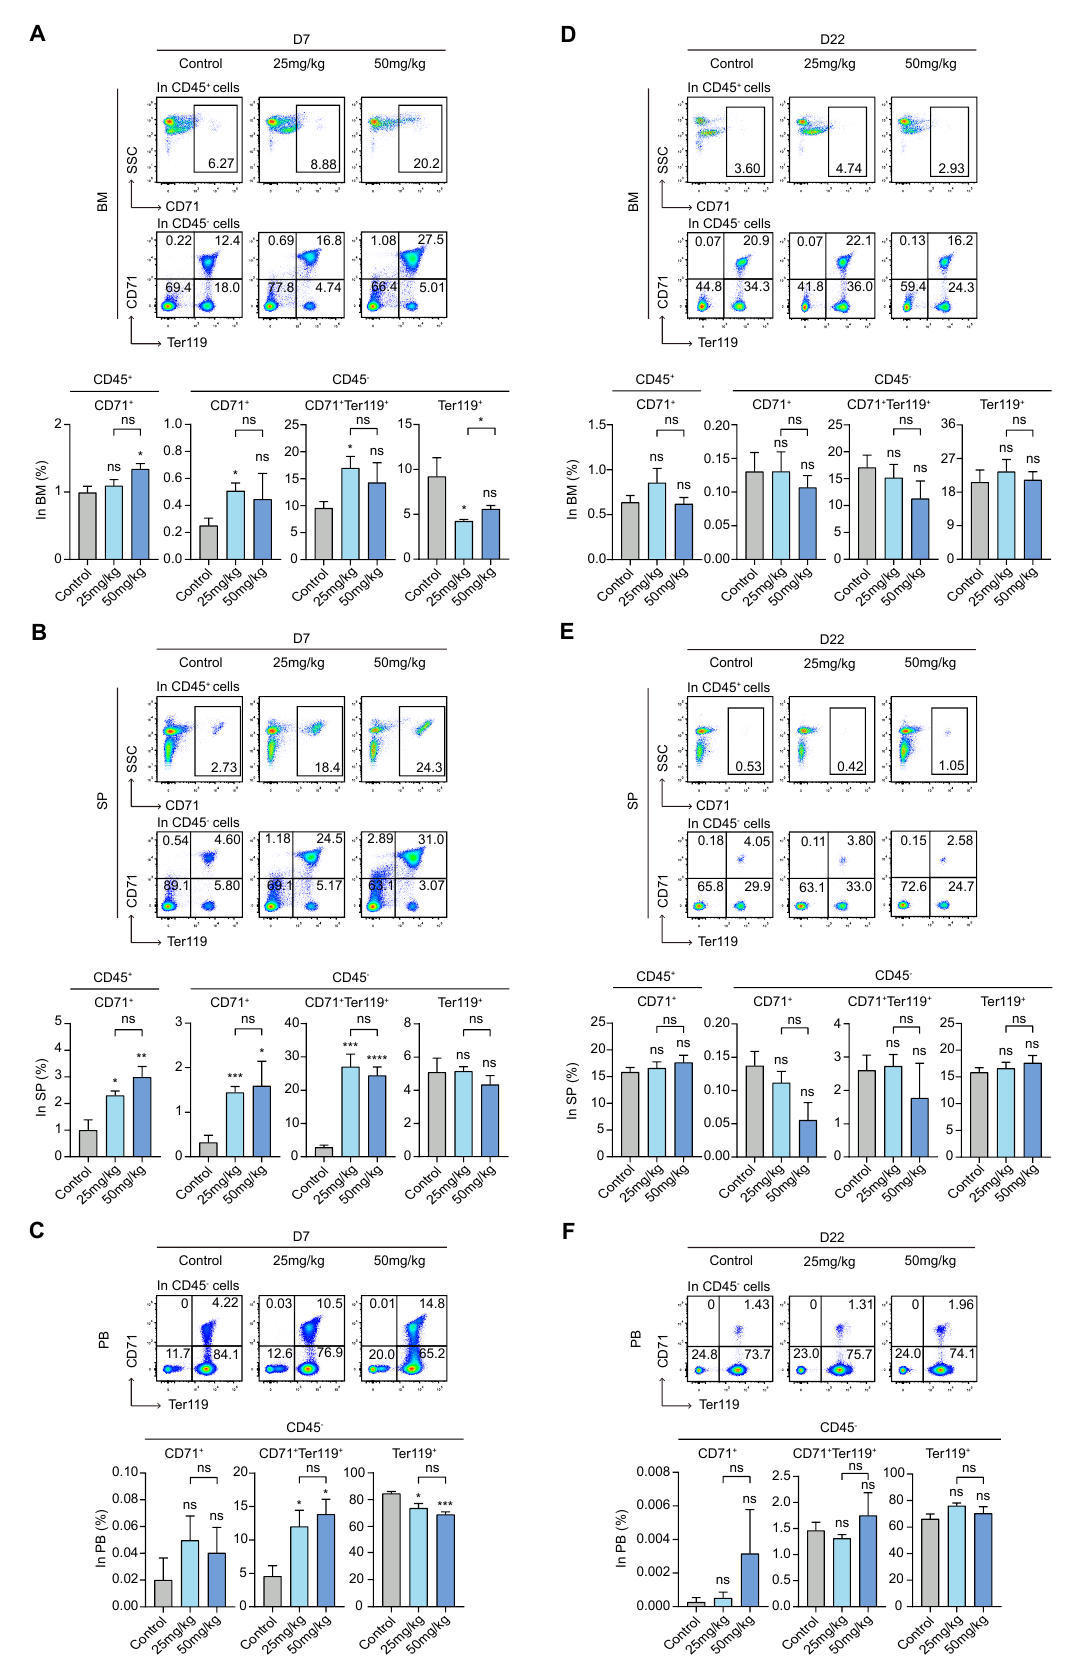
Figure 5. Effect of S63845 treatment on erythroid differentiation in CB6F1 mice. ( A ) Representa- tive FACS profiles and percentages of CD45 + CD71 + , CD45 − CD71 + , CD45 − CD71 + Ter119 + ,